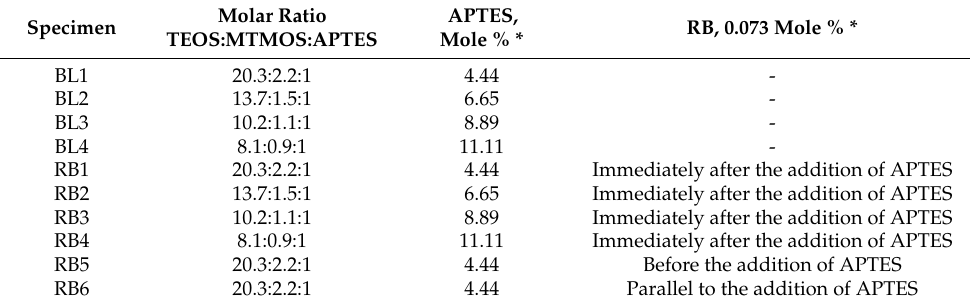
Table 3. Conditions of RB@ORMOSIL matrix